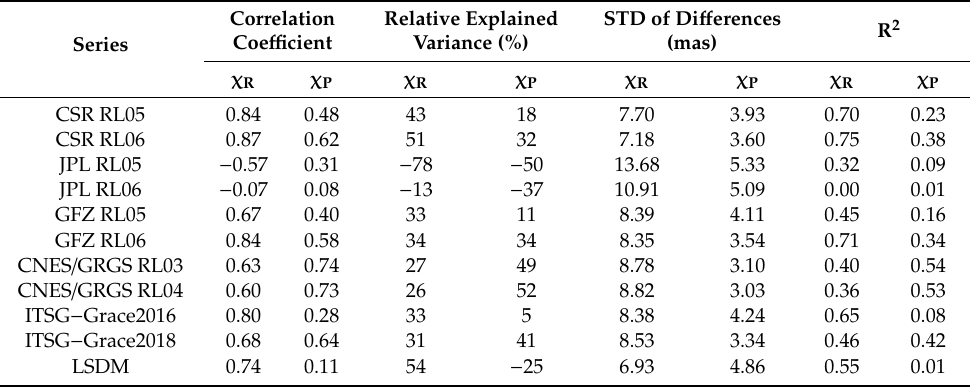
Table A2. Correlation coe ffi cients of χ R and χ P parts of seasonal variation between GAO and HAM computed from GRACE solutions and LSDM model, the percentage of variance in GAO explained by HAM functions, standard deviation (STD) of di ff erences between GAO and HAM, and coe ffi cient of determination (R 2 ). The critical value of the correlation coe ffi cient for 25 independent points and a confidence level of 0.95 was 0.34. The standard error of the di ff erence between two correlation coe ffi cients for 25 independent points was